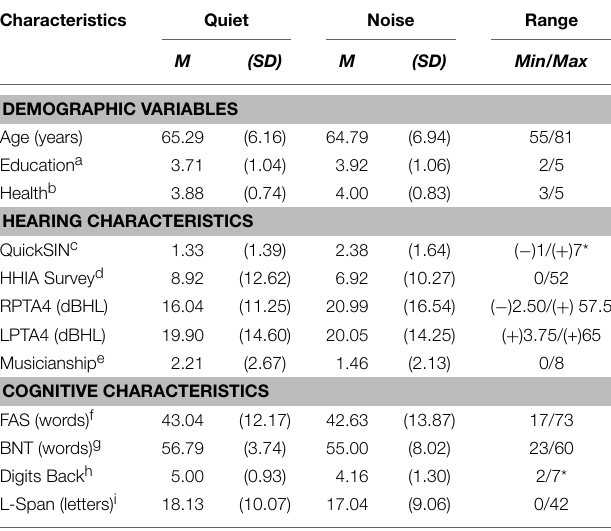
TABLE 1 | Demographics, Hearing, and Cognitive